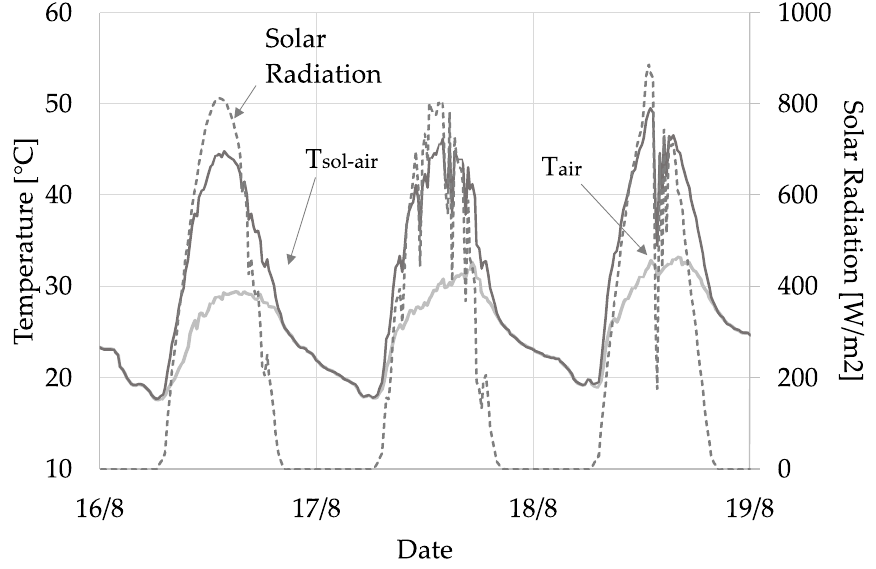
Figure 8. Boundary conditions of the simulation days.